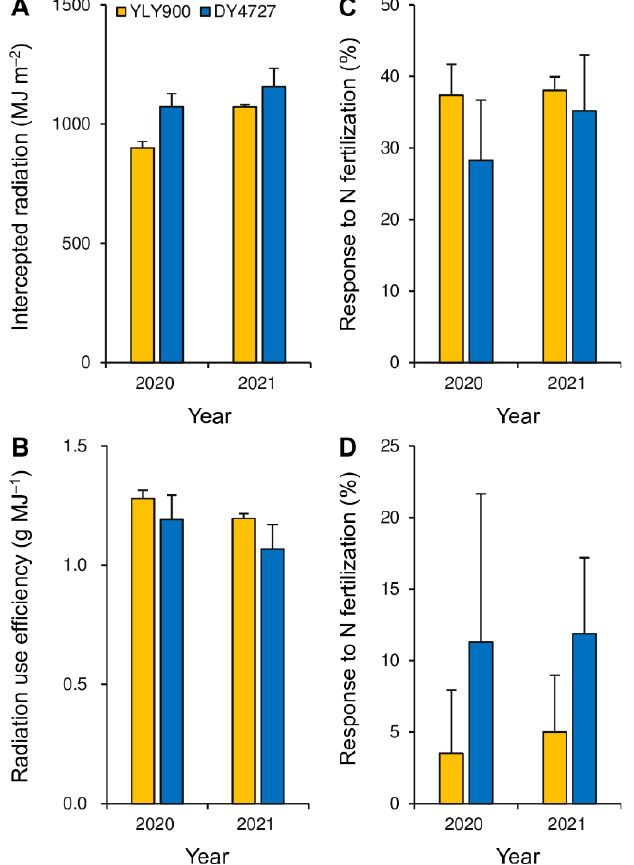
Figure 5. Intercepted radiation ( A ) and radiation use efficiency ( B ) under the zero-N fertilization condition and their responses to N fertilization (180 kg N ha − 1 ) relativized to zero-N fertilization ( C , D ) in two hybrid rice varieties, Deyou 4727 (DY4727) and Y-liangyou 900 (YLY900), grown in 2020 and 2021. Data are means (columns) and standard errors (bars) of three replications.